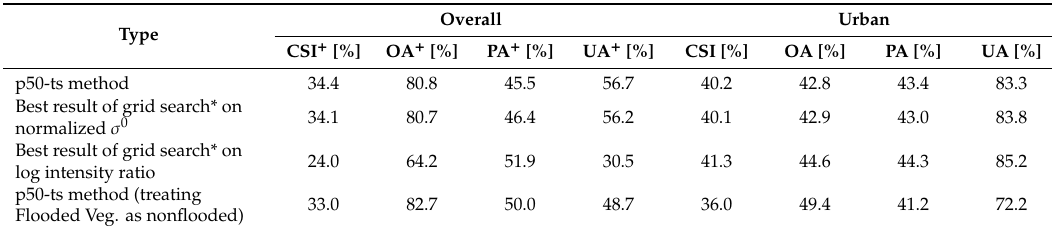
Table 2. Evaluation